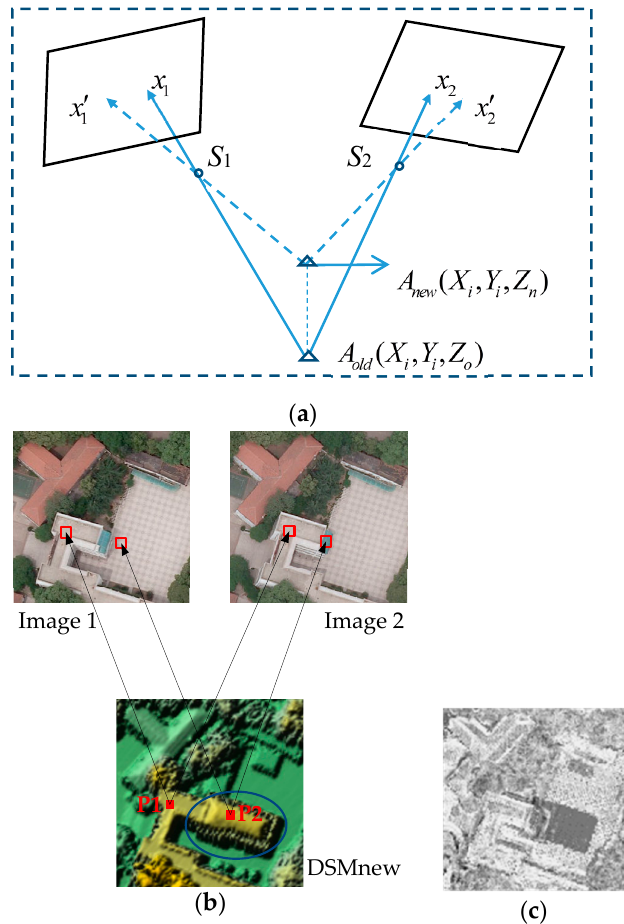
Figure 4. Illustration of grey-scale similarity calculating method: ( a ) illustration of using grey-scale similarity to determine height change; ( b ) projecting each grid center of the DSMnew onto the images and then NCC value is computed; and ( c ) NCC map.